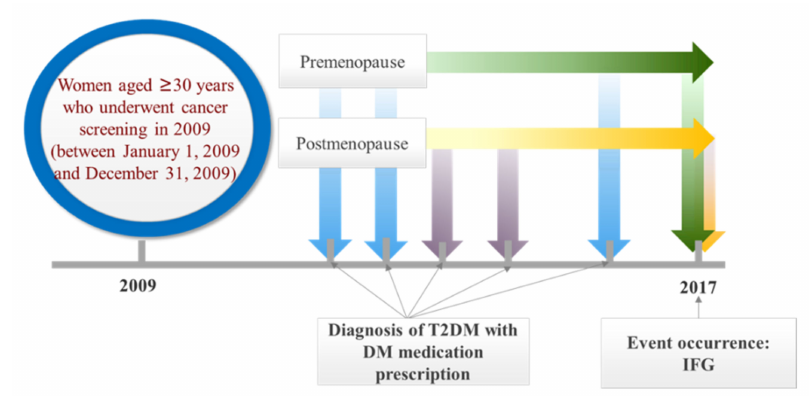
Figure 1. Diagram for the study design.